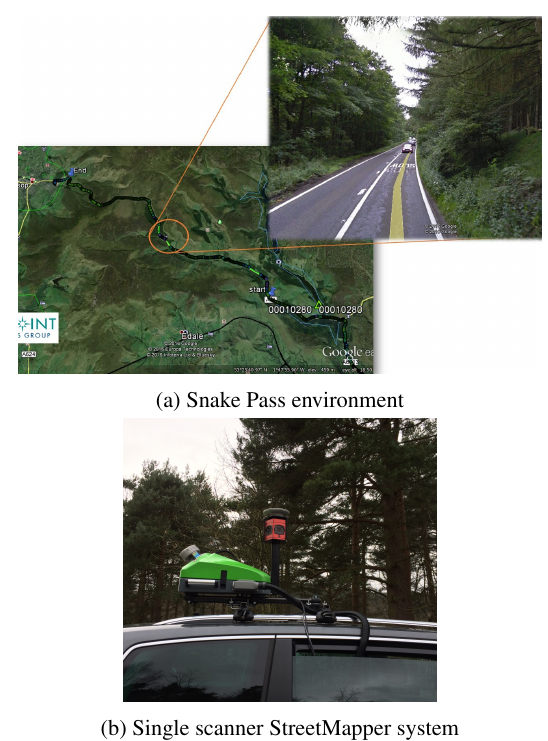
Figure 2: Environment and equipment for Case study 2 on the acquired navigation accuracy.